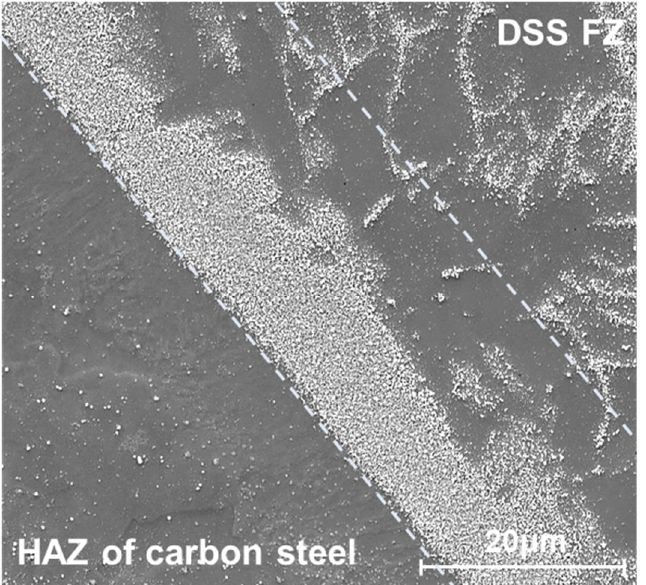
Figure 11. FE-SEM image of the WJ after the Ag decoration near the type-II boundary of the DF. White-dashed lines indicate the type-II boundary region.